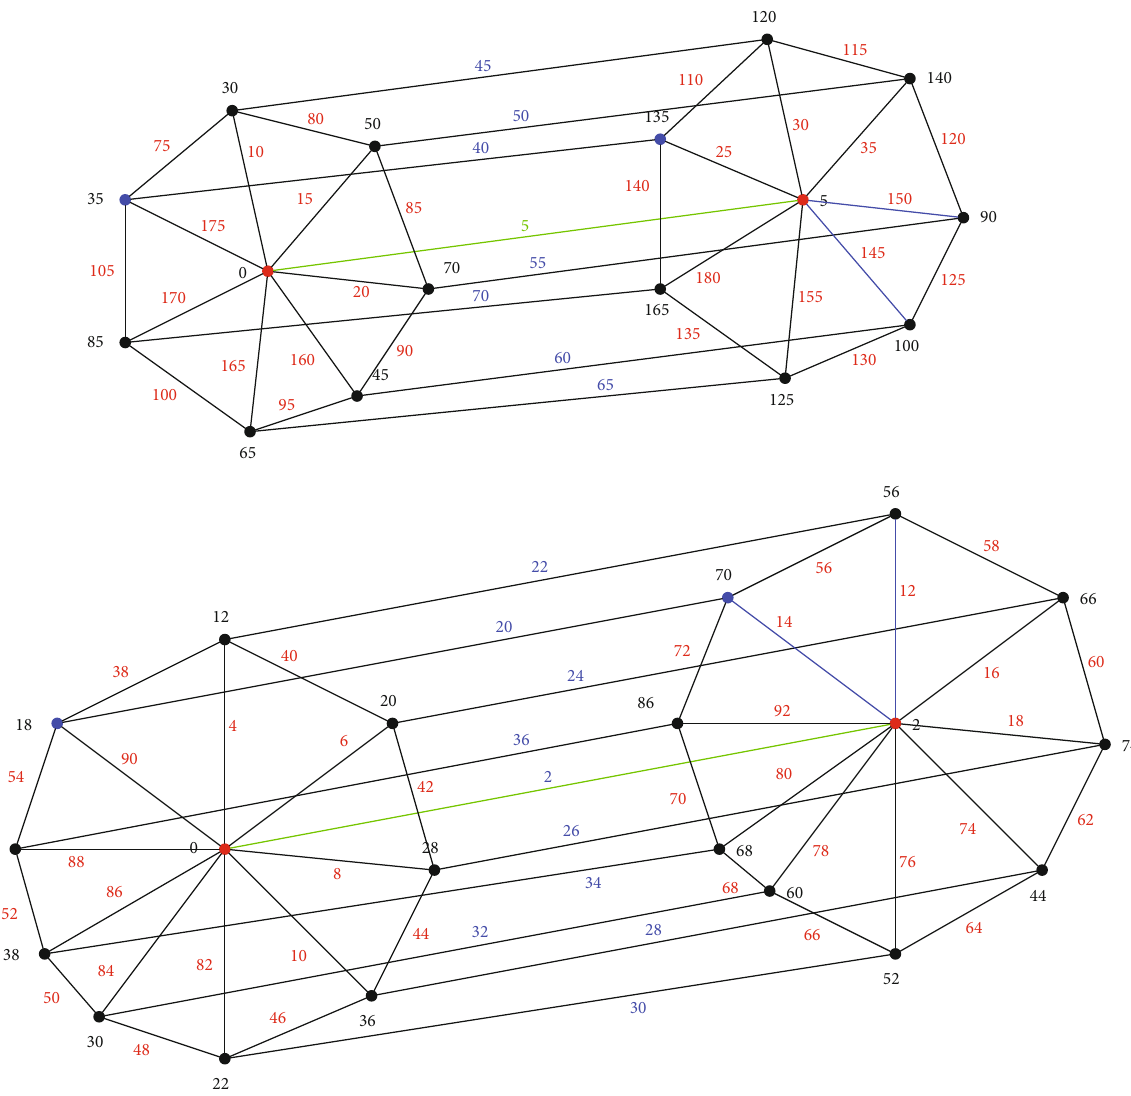
− graceful labeling and P ð W Figure 12: P ð W 7 Þ with an edge 5